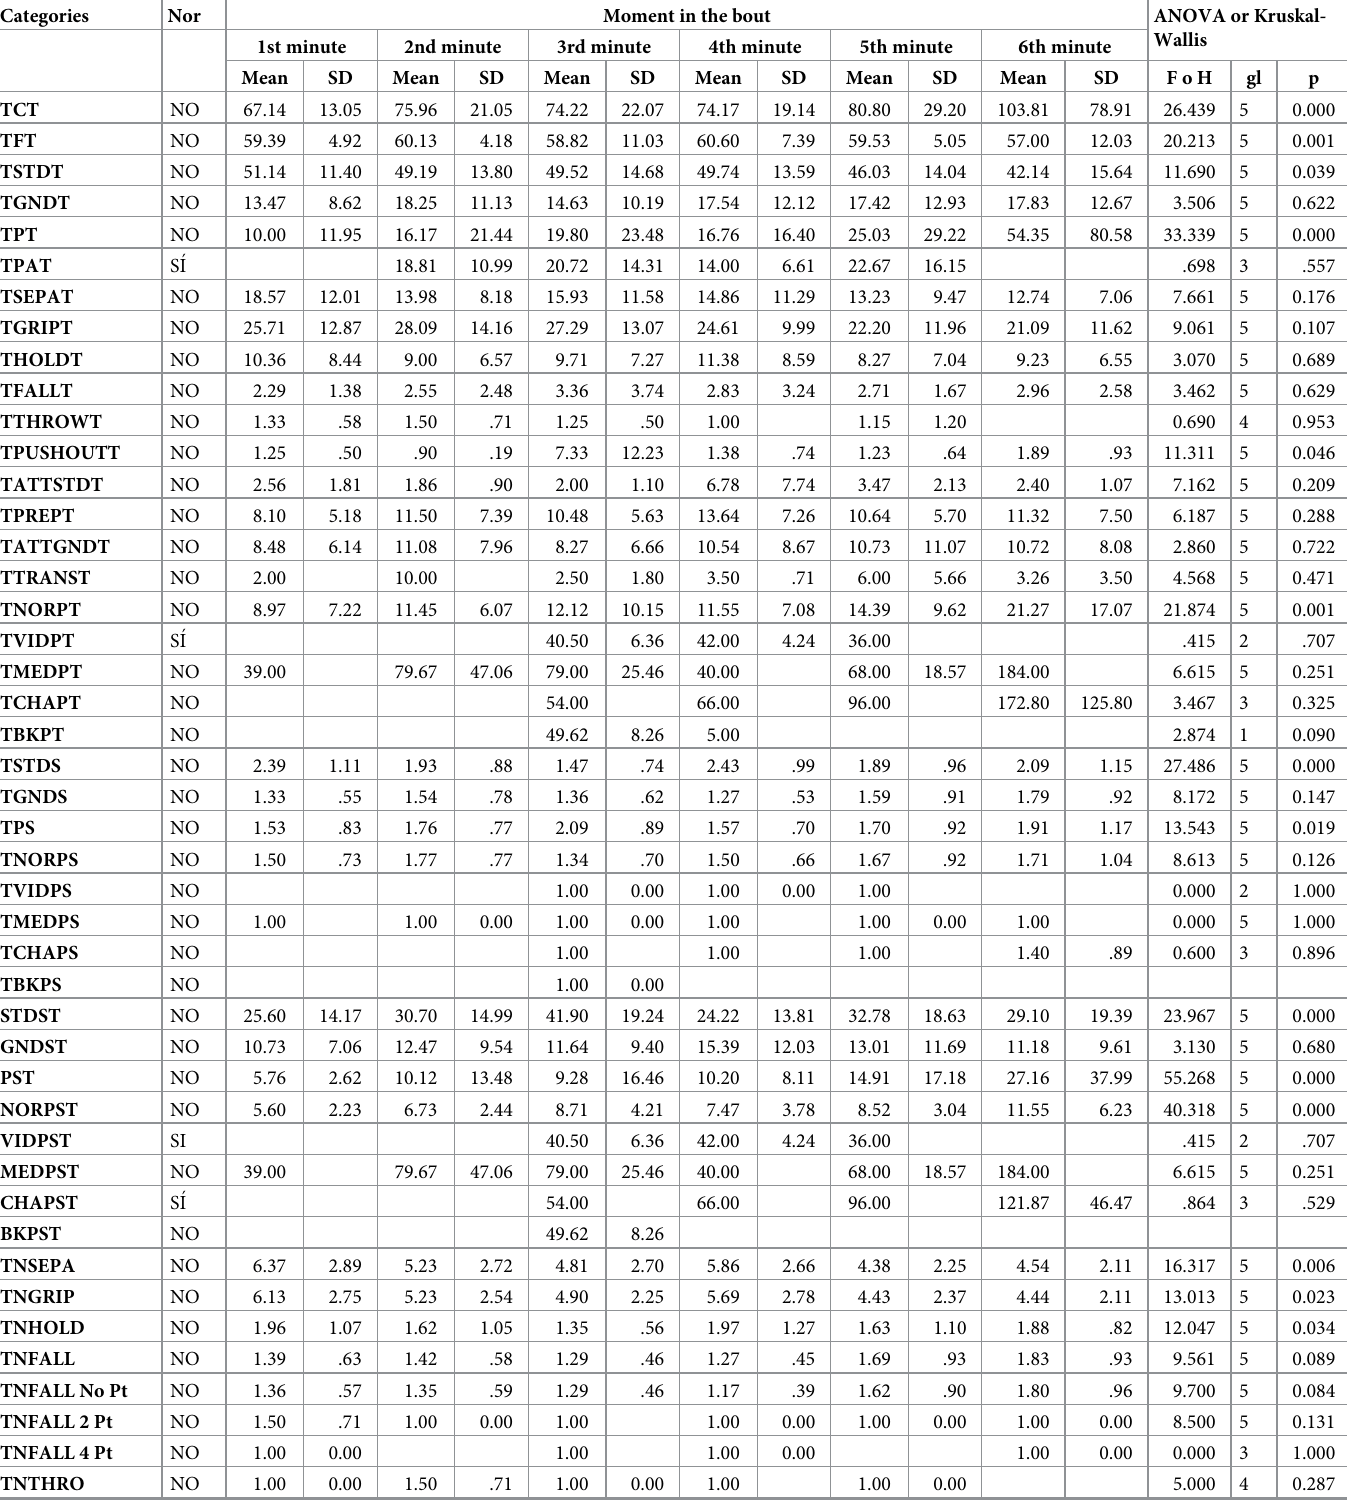
Table 4. Sequential and temporal parameters in the different bout minutes in the 65 kg category.